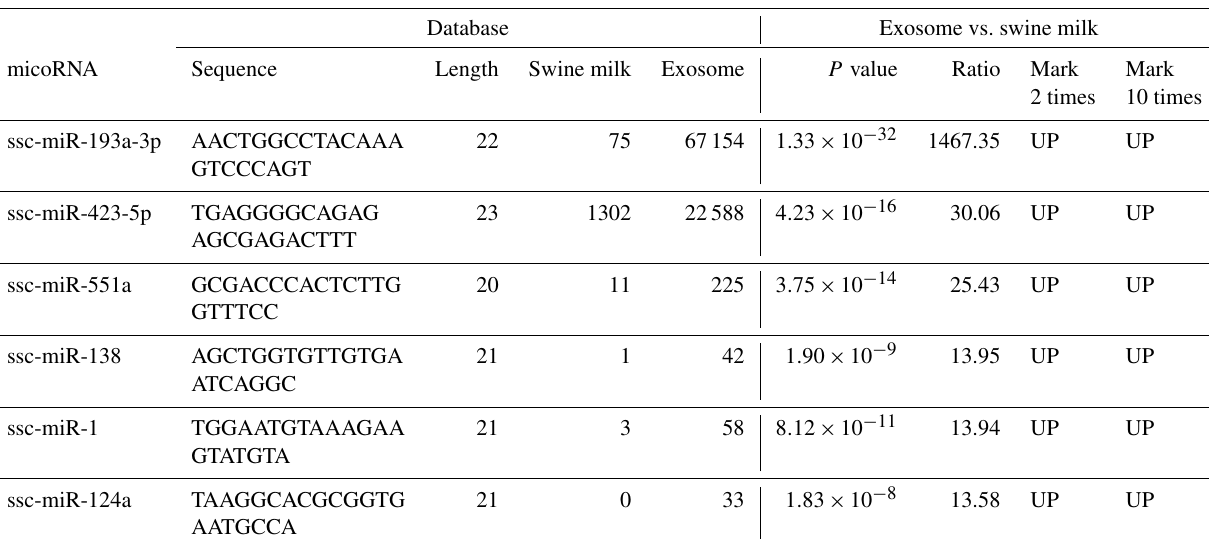
Table 2. High concentration of miRNA in exosomes.